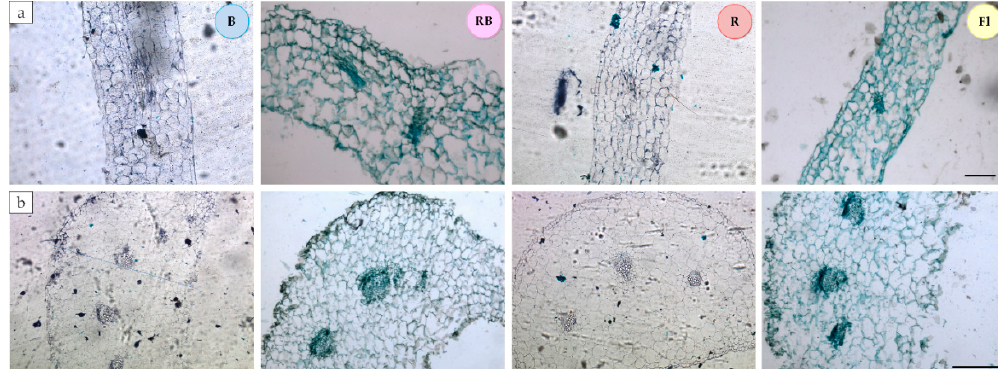
Figure 3. Anatomical structure of gerbera leaves grown under different light conditions and in the medium containing 5 µM BA; ( a ) leaf blade cross-section, ( b ) petiole cross-section; B—100% blue LED, RB—mixed red and blue LED (7:3); R—100% red LED; Fl—control, white fluorescent lamp; scale bar, 100 µm. Agronomy 2020 , 10 , x FOR PEER REVIEW